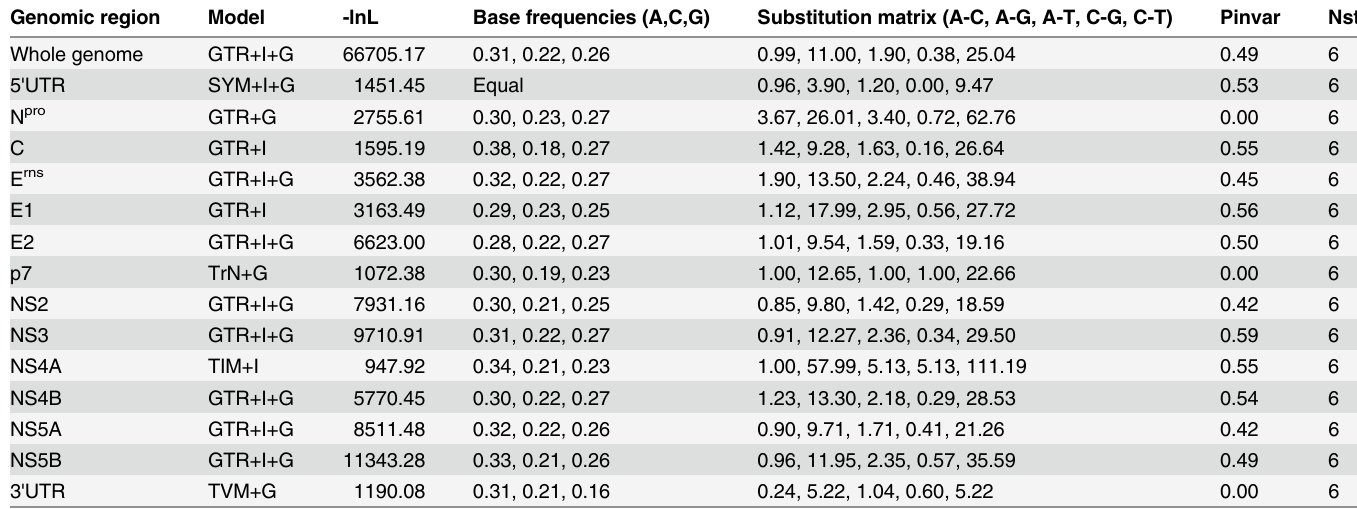
Table 2. The best fit evolutionary models estimated for CSFV genomic regions with Modeltest 3.7. Genomic region